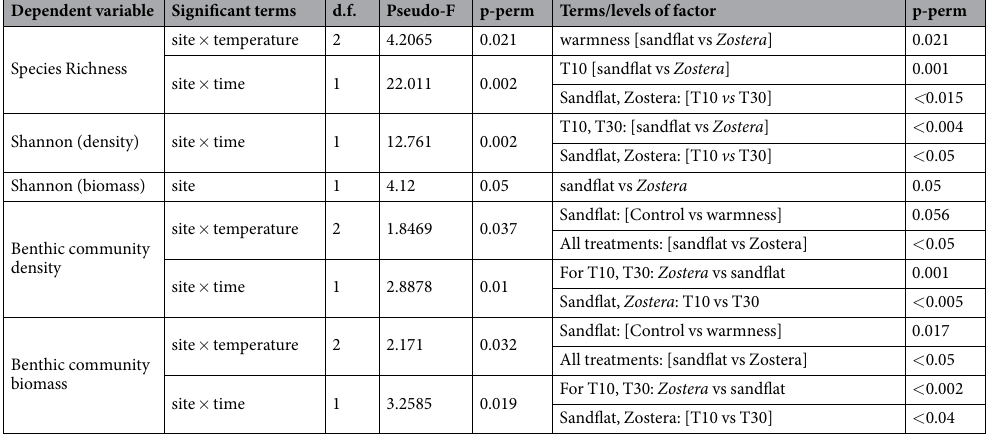
Table 1. Summary of significant terms from the 3-way PERMANOVA analyses, with macrobenthic community and respective diversity indices as dependent variables, and site, treatment and time as explanatory variables, with indication of the significant pairwise